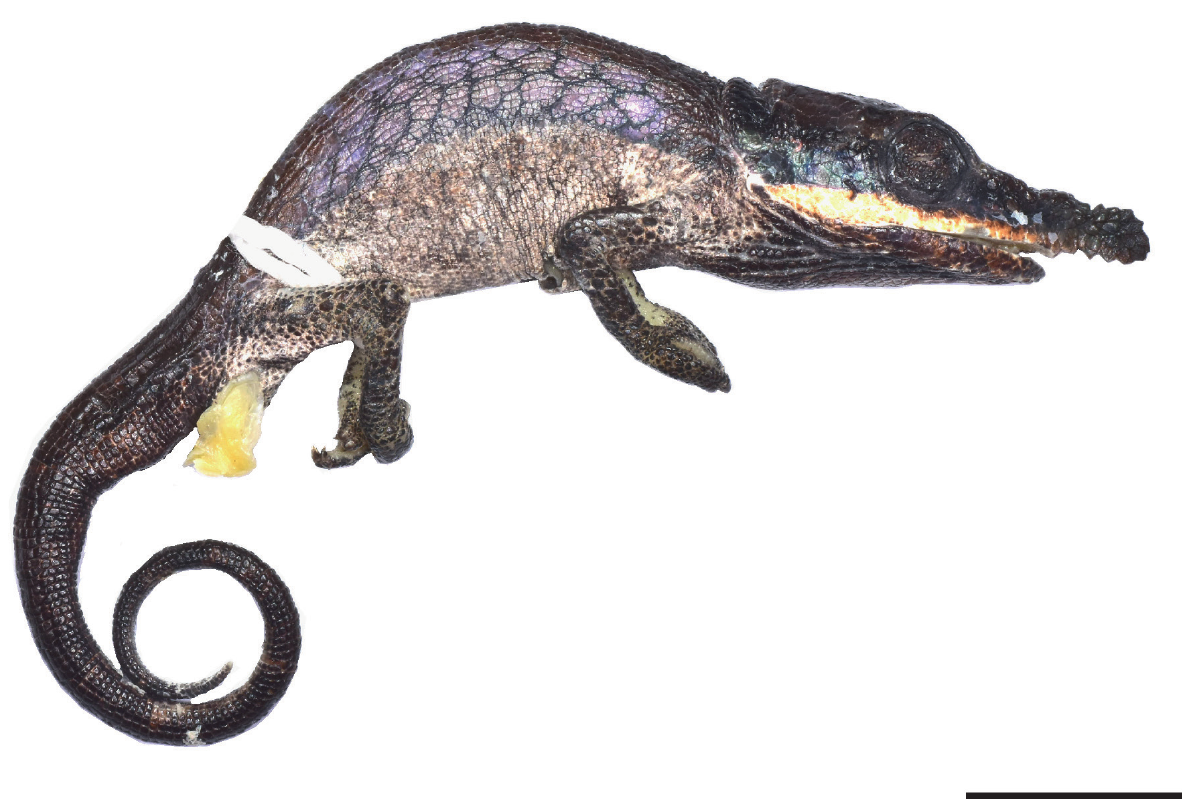
Figure 3. Preserved holotype (KU 343178) of Calumma roaloko sp. n. Scale bar = 10